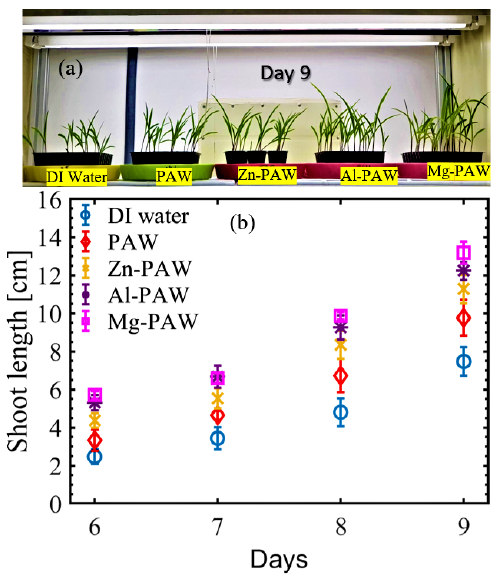
Figure 3. Germination of corn seeds watered with DI water, PAW, PAW with Zn (Zn-PAW), PAW with Al (Al-PAW), or PAW with Mg (Mg-PAW) after sowing on cotton. ( a ) Photograph of Seedling growth on the 4th day after sowing. ( b ) Average germination rate at the end of the 2nd, 3rd, 4th, and 5th days after sowing.